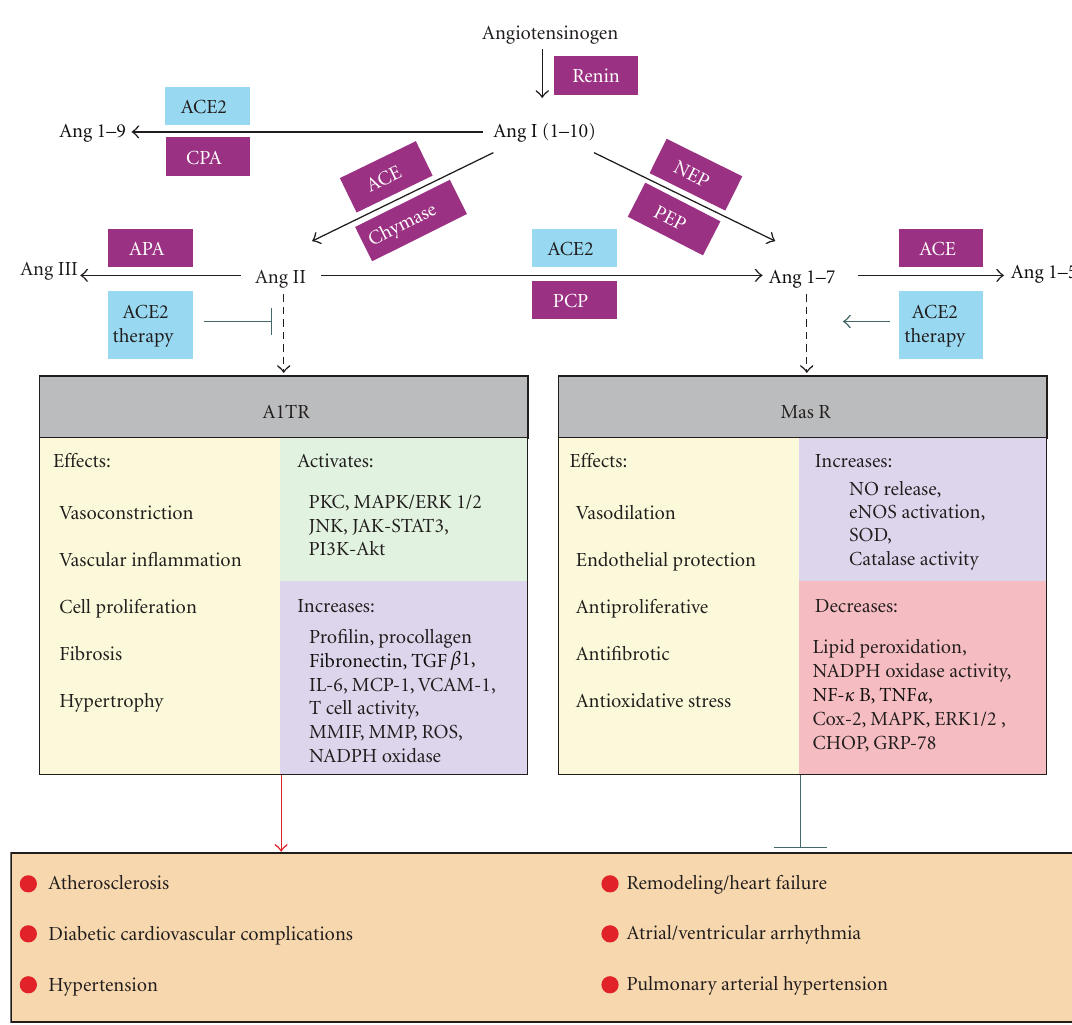
Figure 1: The enzymatic cascade involved in the renin-angiotensin system, key receptor systems, and the biological e ff ects mediated by Ang II and Ang 1–7. Solid black lines, enzymatic pathways; Broken lines, peptide agonist interacting with its key receptor; Green arrow, stimulatory e ff ects; Red arrow, pathologic e ff ects; Green bars; inhibitory e ff ects. ACE2: angiotensin-converting enzyme; Akt: protein kinase B; Ang: angiotensin; APA: aminopeptidase A; AT1R Ang II type 1 receptor; CHOP: CCAAT/enhancer binding protein homologous protein; Cox-2: cyclooxygenase-2; CPA: carboxypeptidase A; eNOS: endothelial synthase; ERK: extracellular signal-regulated kinase; GRP- 78: glucose regulated protein; IL-6: interleukin-6; JAK-STAT: Janus Kinase- signal transducer and activator of transcription system; JNK: C-jun-N-terminal kinase; MAPK: mitogen activated protein kinase; Mas R: Ang 1–7 receptor; MCP-1: monocyte cheomattractant protein 1; MMIF: macrophage migration inhibitory factor; MMP: matrix metalloproteinase; NADPH: nicotinamide adenine dinucleotide phosphate; NEP: neutral endopeptidase; NF-kappaB: nuclear factor kappa-light-chain-enhancer of activated B cells; NO: nitric oxide; PCP: prolyl carboxypeptidase (also known as angiotensinase C); PEP: prolyl endopeptidase; PI3K: phosphatidylinositol 3-kinases; PKC: protein kinase C; ROS: reactive oxygen species; SOD: superoxide dismutase; TGF β 1, transforming growth factor β 1; TNF α : tumor necrosis factor α ; VCAM-1: vascular cell adhesion